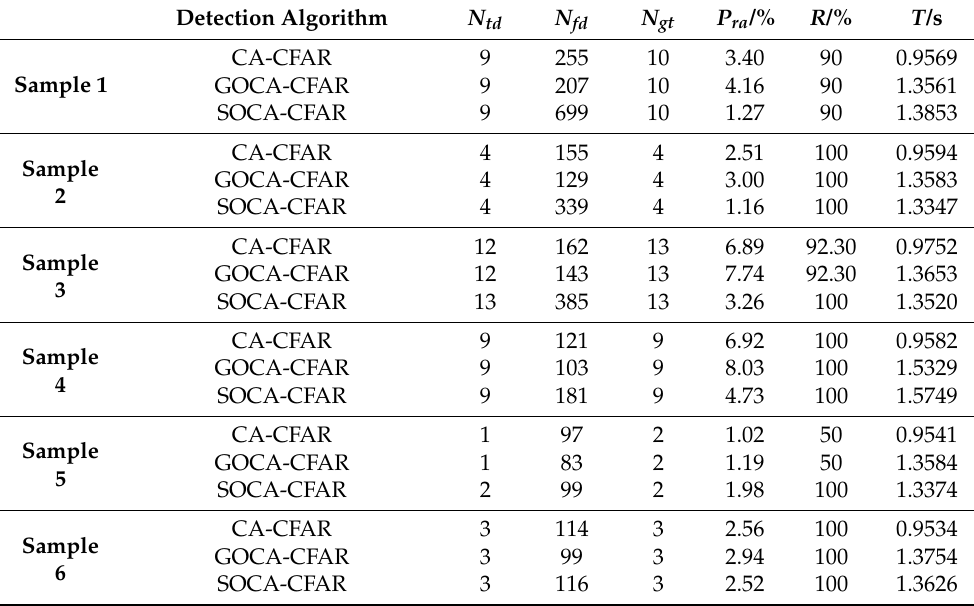
Table 2. Statistics of the detection results of the samples for the CA-CFAR, GOCA-CFAR, and SOCA-CFAR